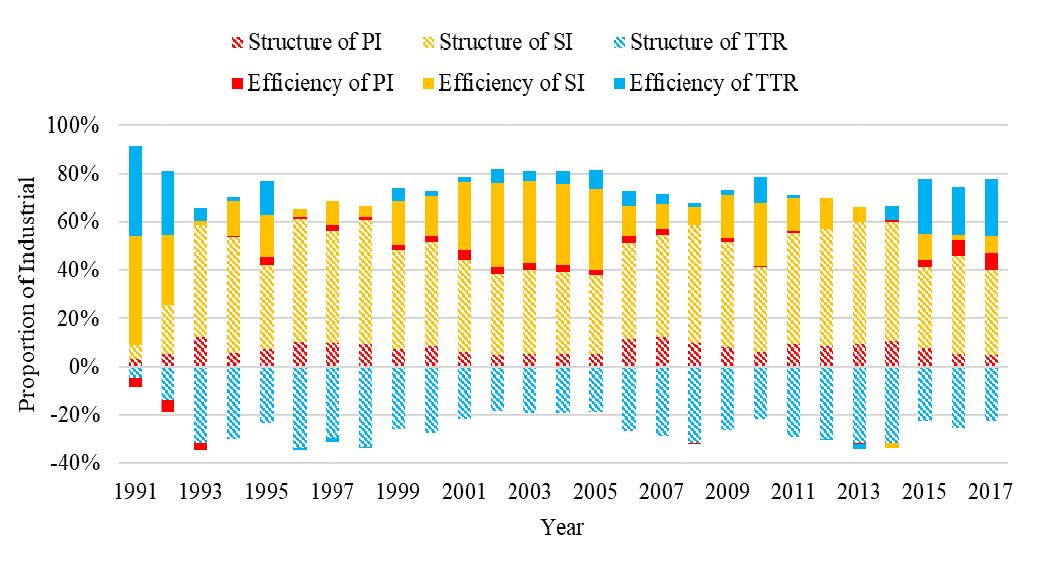
Figure 2. The proportion of structural factors and efficiency factors of energy intensity (EI).